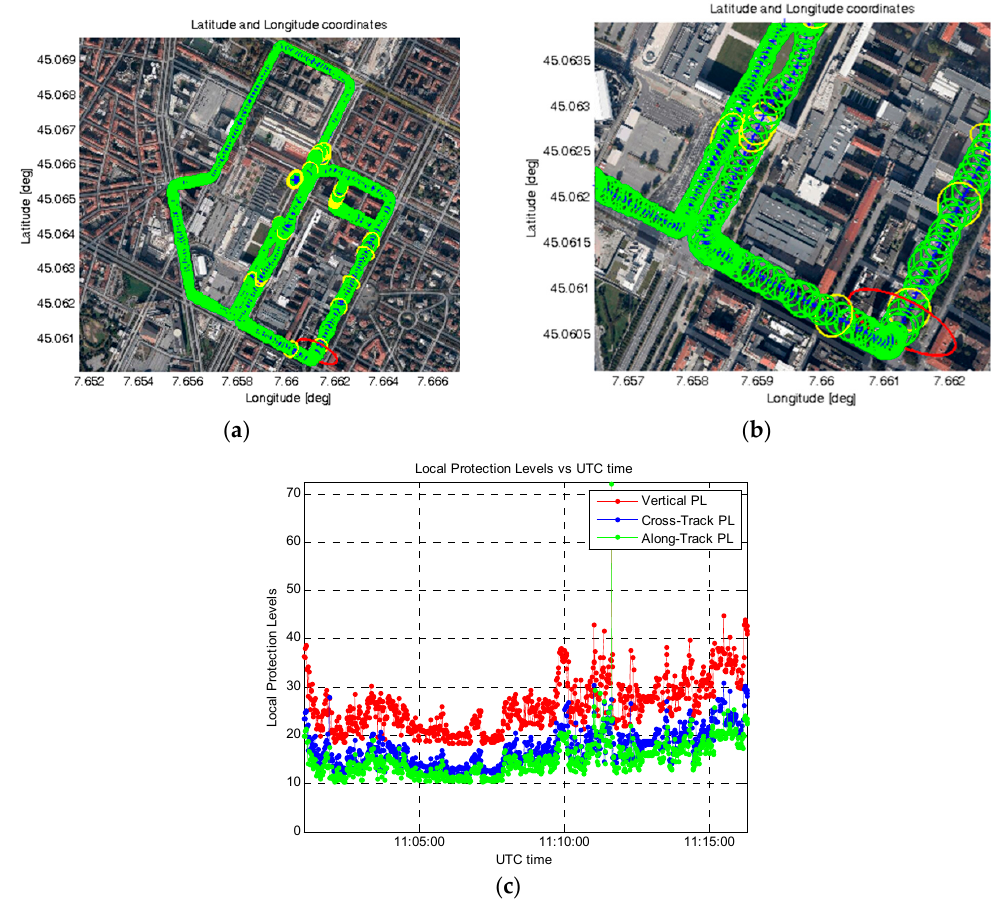
Figure 13. Results obtained on the selected demonstration path: ( a ) Estimated positions and LPL ellipses on the entire path; ( b ) Magnification of a small portion of the path; ( c ) LPL values computed along the entire path versus UTC time.